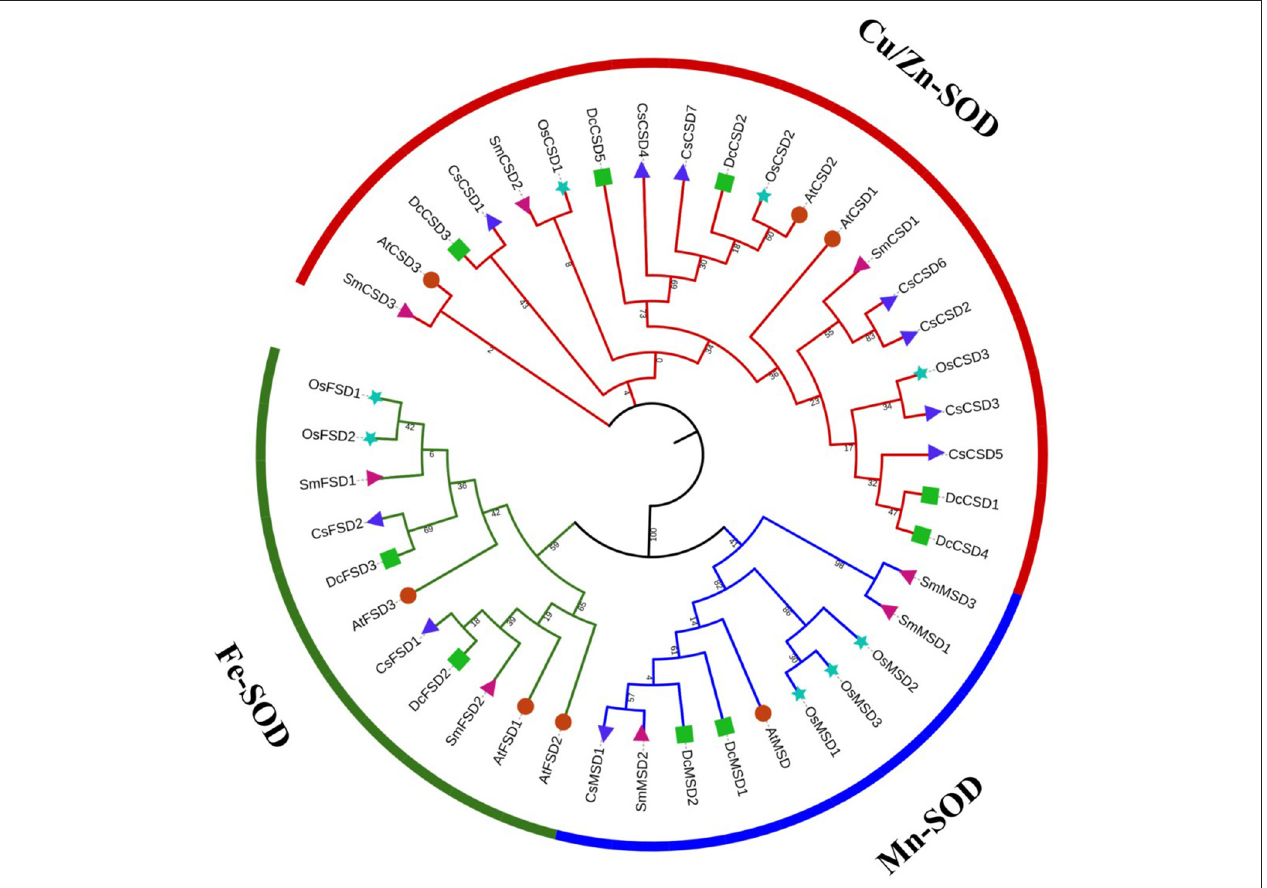
FIGURE 2 | Phylogenetic tree analysis of SOD family genes of D. carota and other species. In this tree, different symbols are representing different plants: green square for D. carota , powder-blue star for Oryza sativa , red circle for Arabidopsis thaliana , blue triangle for Camellia sinensis, and pink triangle for Salvia miltiorrhiza . Three different strips represent the different groups. The phylogenetic tree was constructed using the MEGA7 maximum likelihood method.